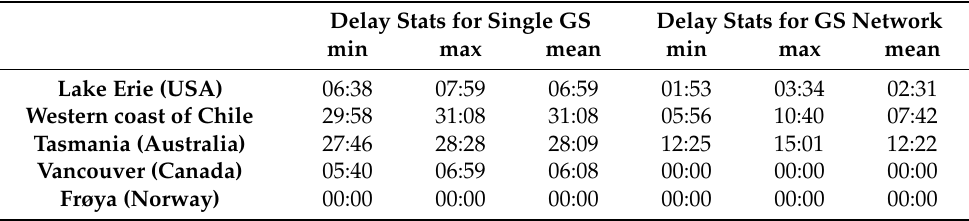
Table 1. Statistics for dense and sparse ground station coverage (mm:ss) for one week, showing the delay from end of an observation to the first available ground station.